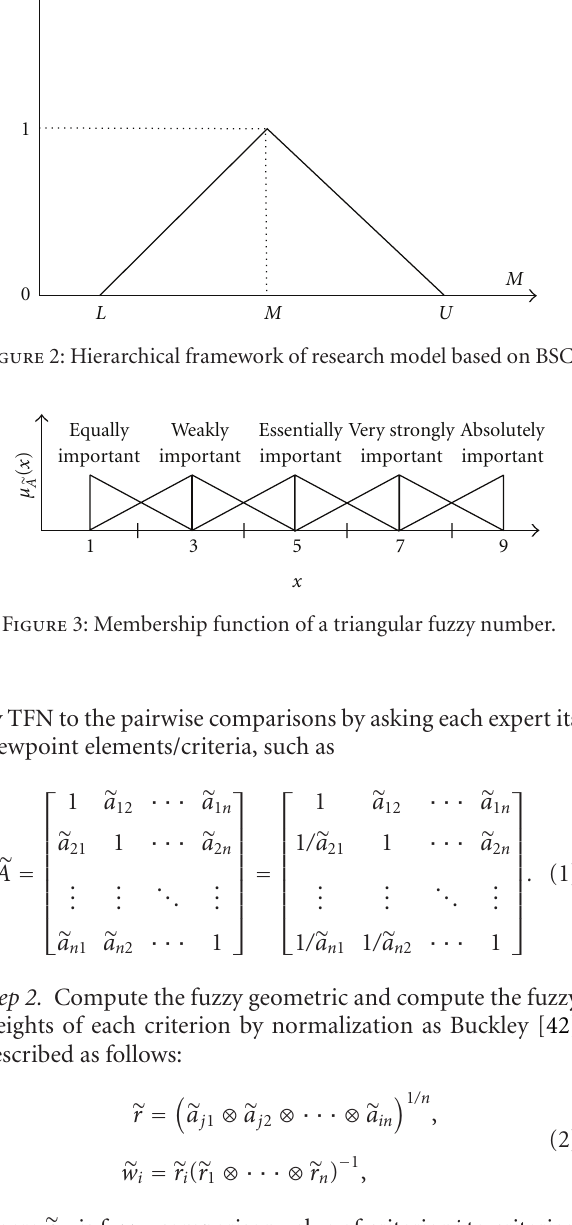
The sign “ (cid:4) ” indicates the computation of the fuzzy num- bers, consisting of fuzzy addition and fuzzy